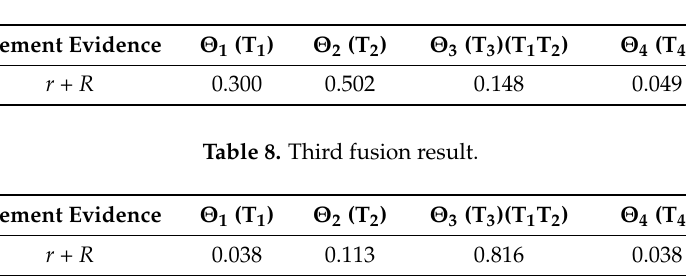
Table 7. Second fusion result.